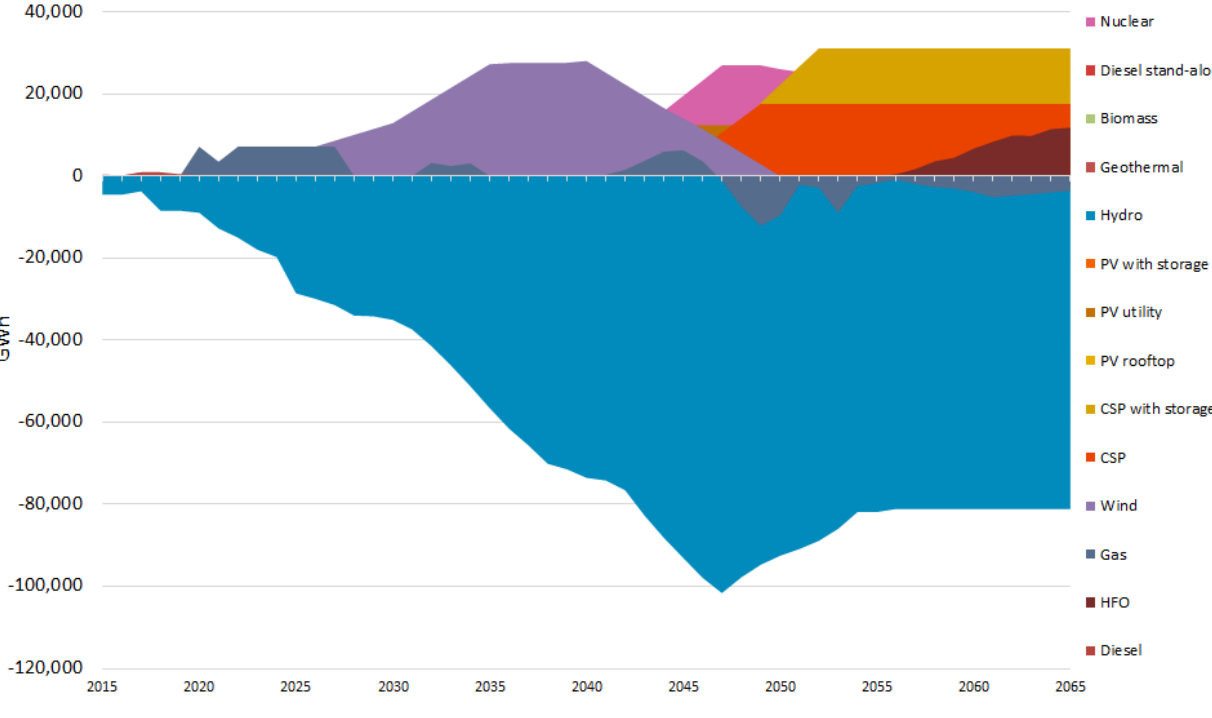
Figure 4. Comparison of electricity supply mix between Drought vs. New Policy Scenario.